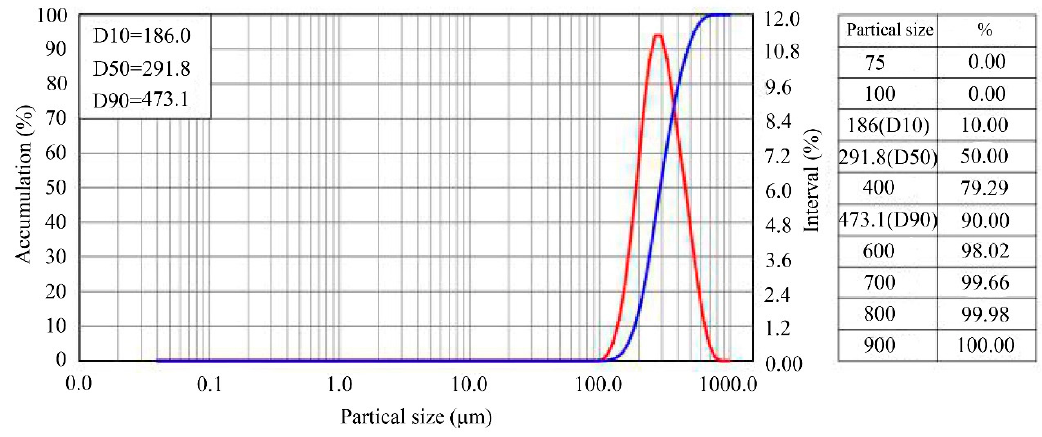
Figure 3. Particle size distribution of the test sand (red line, relationship between the sediment particle size and volume; blue line, relationship between the sediment particle size and the cumulative volume).